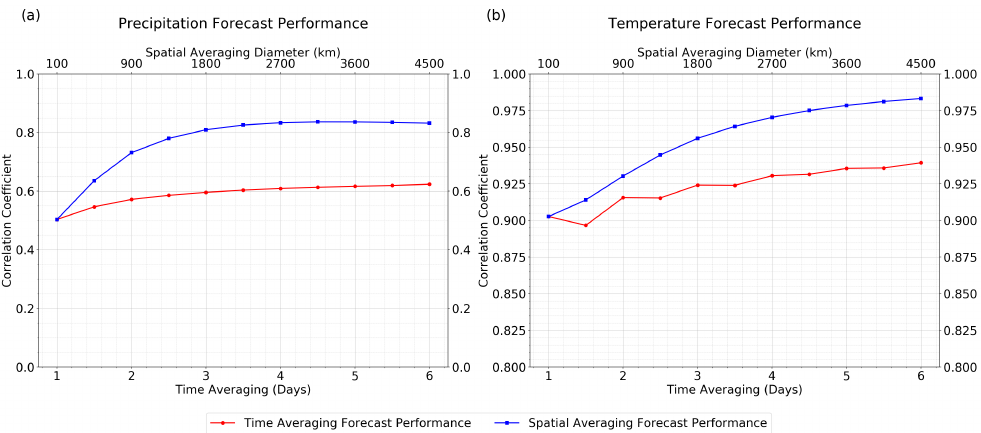
Figure 7. Effect of time and space averaging on forecast performance, averaged globally. ( a ) Precipi- tation, at a lead time of 3 days. ( b ) Surface temperature, at a lead time of 7